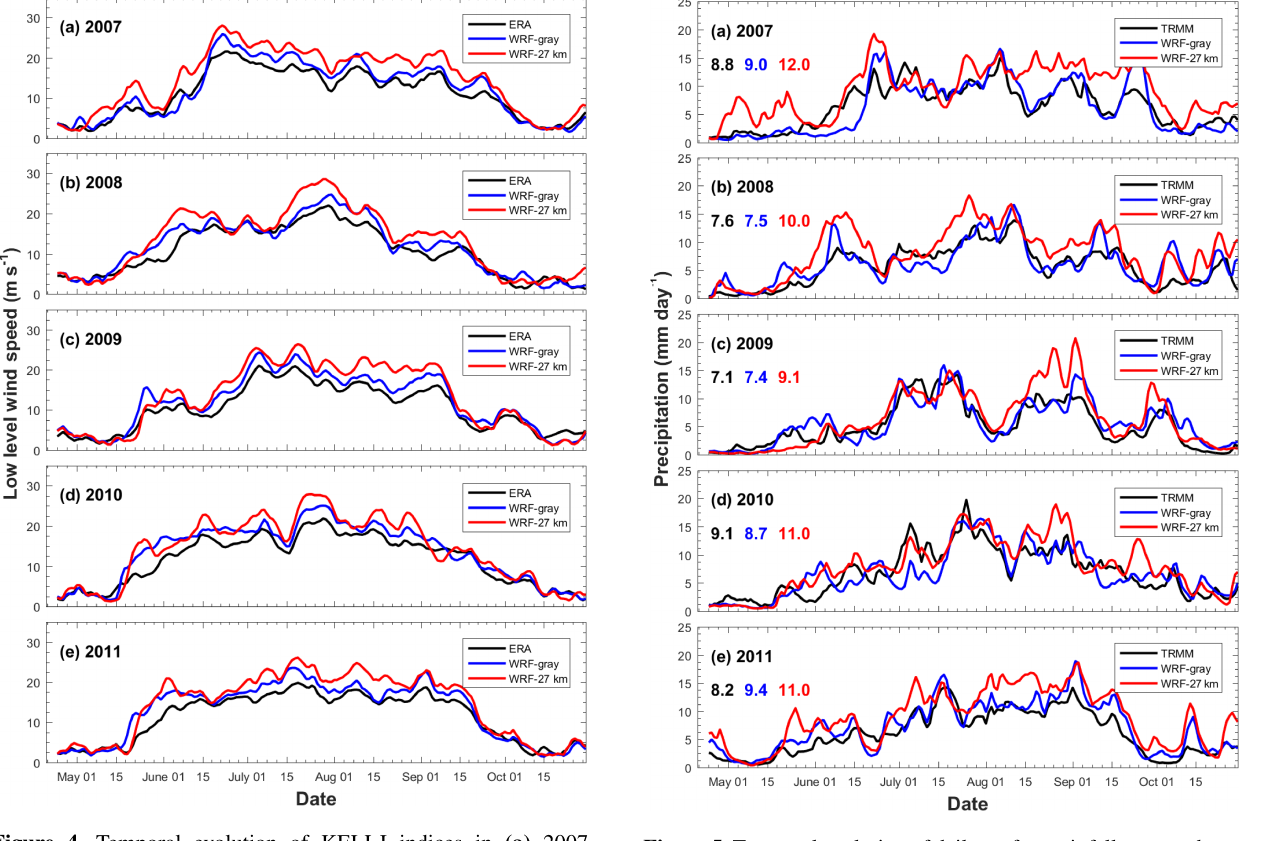
Figure 5. Temporal evolution of daily surface rainfall averaged over the Indian subcontinent in (a) 2007, (b) 2008, (c) 2009, (d) 2010, and (e) 2011 from TRMM (black lines), WRF-gray (blue lines), and WRF-27km (red lines). A 5-day moving average is applied to the time series. The seasonal mean (June to September) of daily surface rainfall amounts averaged over the Indian subcontinent from TRMM (black), WRF-gray (blue), and WRF-27km (red) are also shown in the